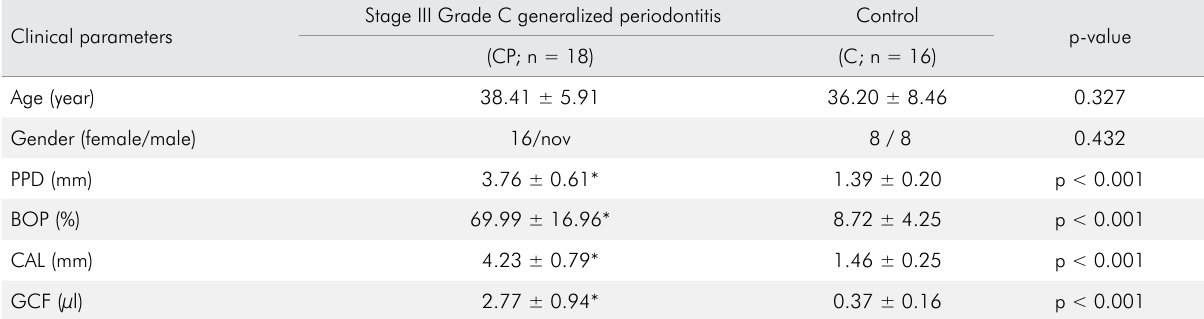
Table 1. Comparison of clinical periodontal parameters and GCF volumes between periodontitis and healthy groups. Clinical